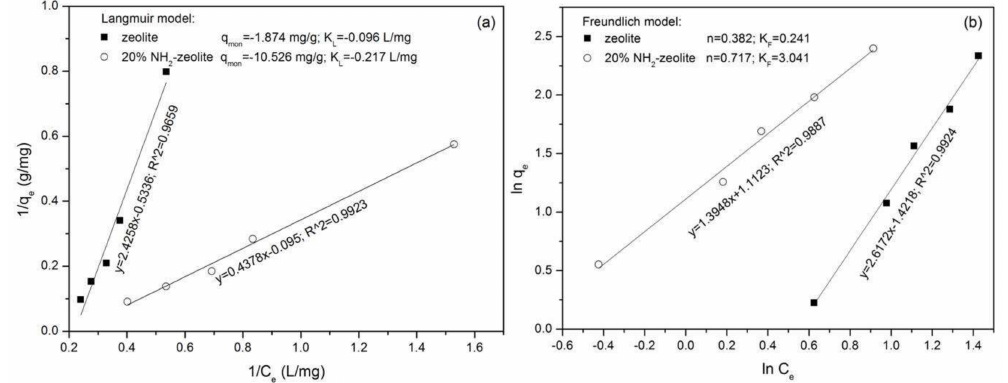
Figure 15. Langmuir ( a ) and Freundlich ( b ) plots for adsorption of naphthalene onto the zeolite and amino functionalized zeolite